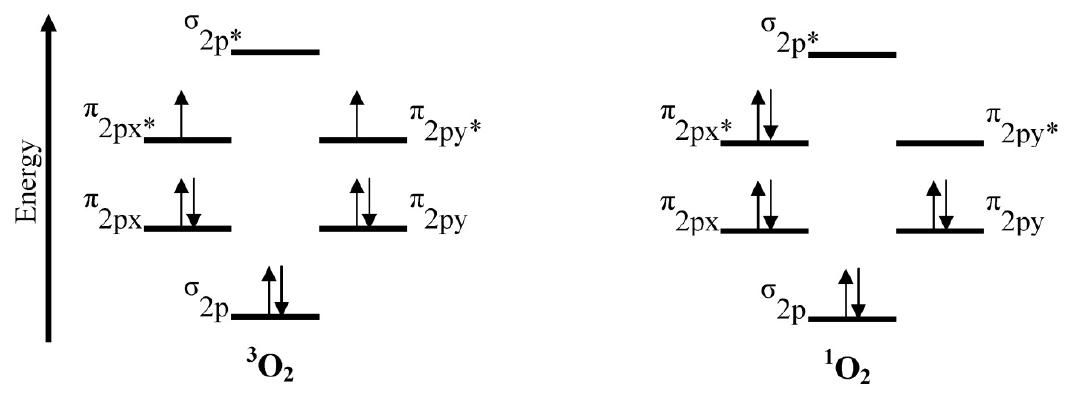
) and singlet ( 1 O 2